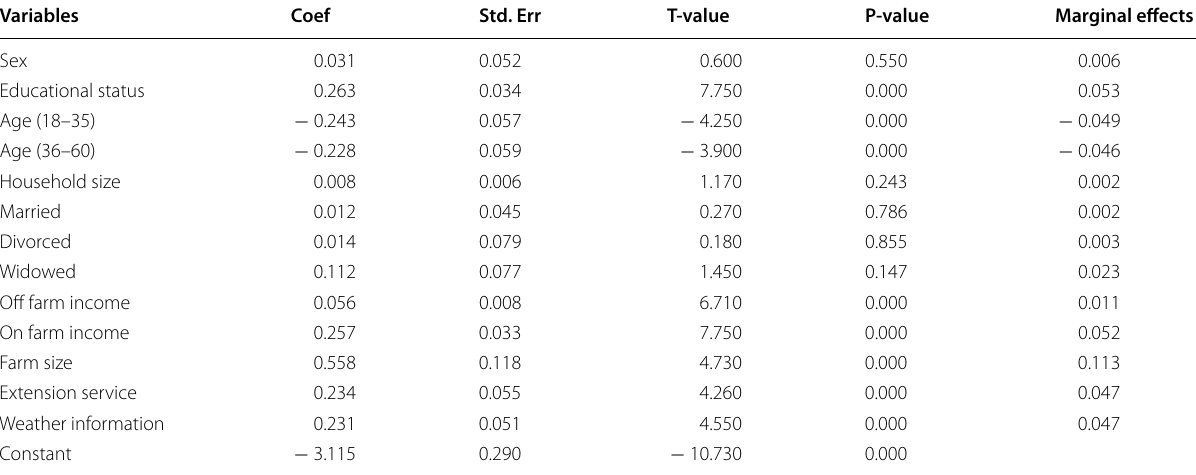
Table 5 Factors that affect rural households’ choice of adaptation strategies